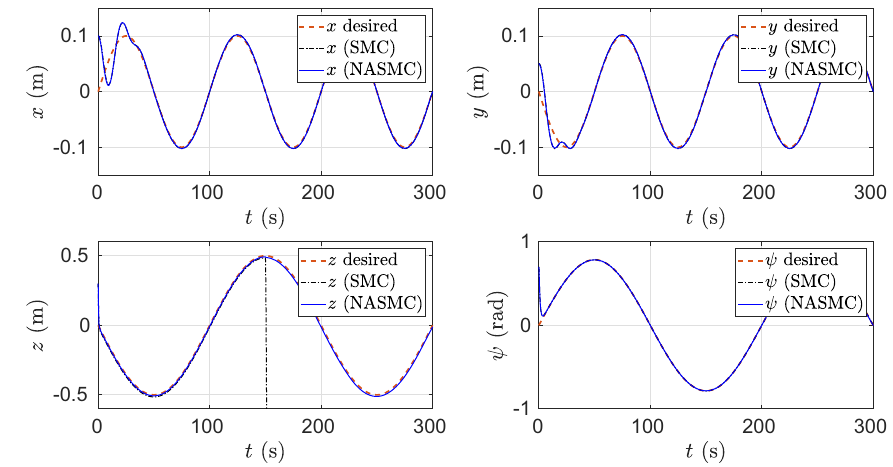
Figure 6: States tracking of the quadcopter system using SMC and